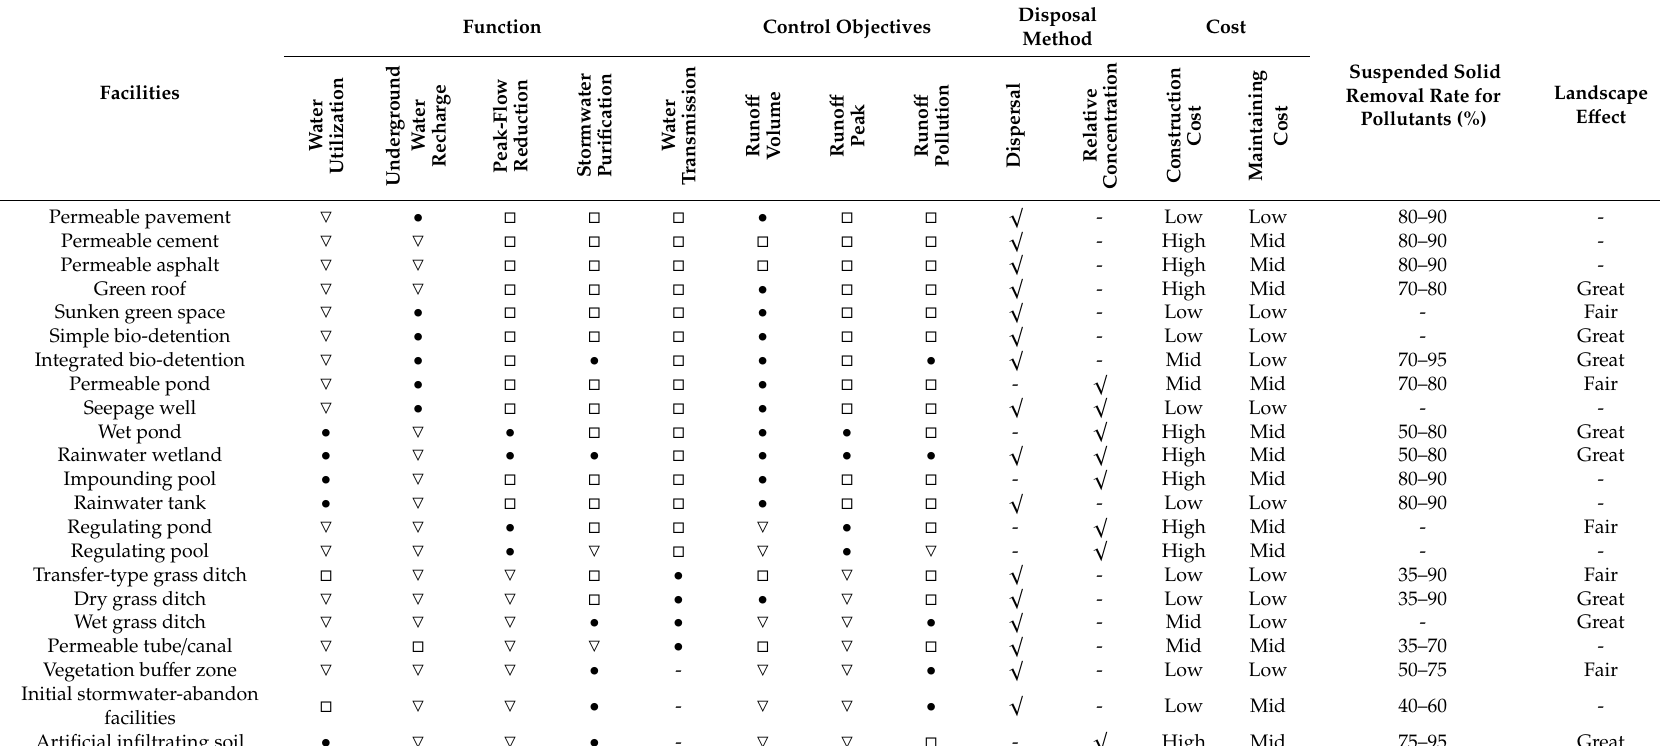
Table 3. SCP technical measures